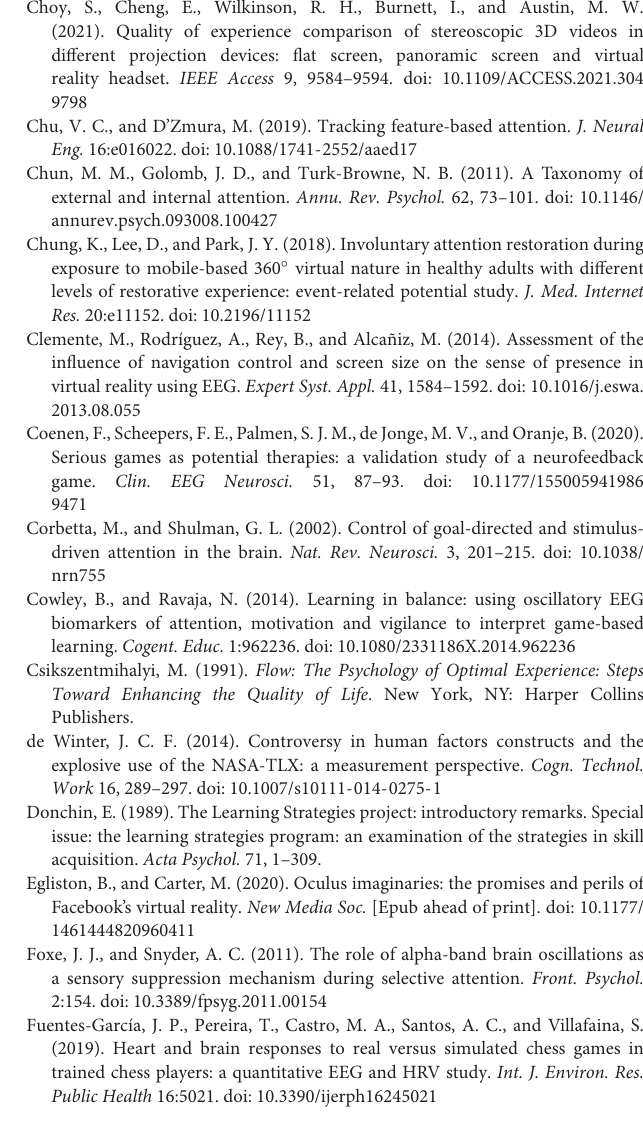
Supplementary Table 1 | Attention allocation studies organized by immersion level